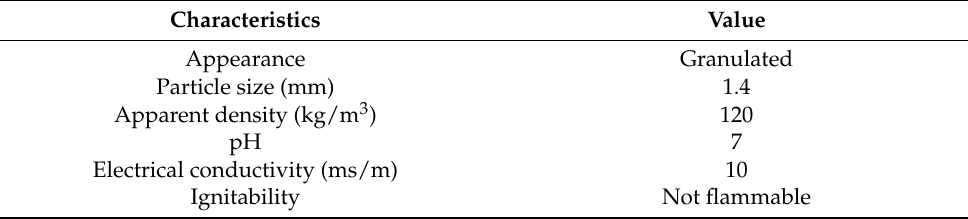
Table 2. Vermiculite properties.